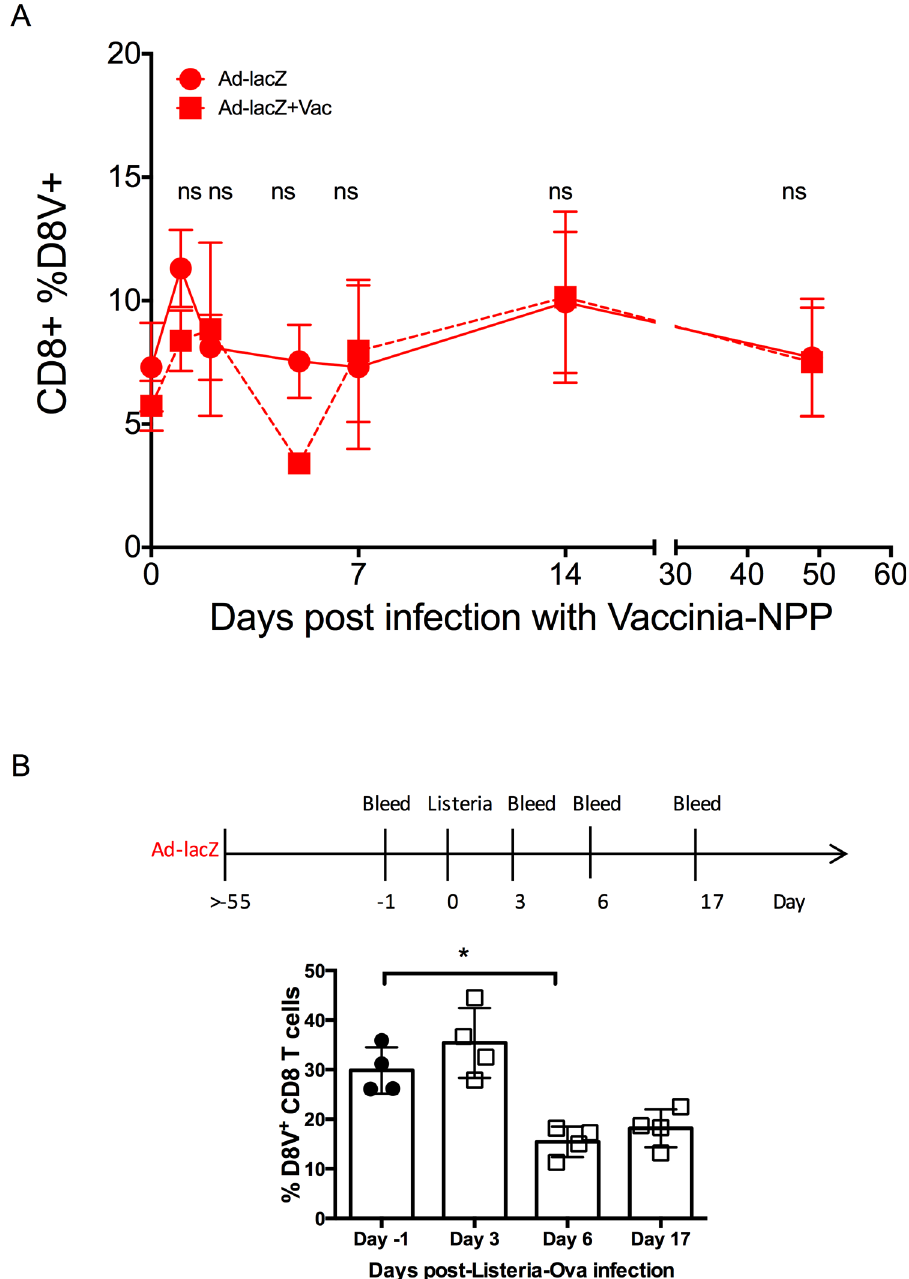
Fig 7. Effect of other infections on pre-existing Ad-lacZ memory responses. (A) C57BL/6 mice were first immunized with Ad-lacZ and then 50 days later were infected with vaccinia i.p. The levels of pre-existing CD8 + D8V + in the blood after vaccinia infection was measured by ex vivo tetramer staining (N = 3 from one of two independent experiments). (B) Mice were immunized with Ad-lacZ, then > 55 days later were infected with i.v. with 1x10 3 cfu/200μl Listeria-OVA. Blood was collected at the indicated timepoints, and the levels of CD8 + D8V + cells measured by surface staining. p values were obtained using T-tests (cid:3) p < 0.05. tetramer + population 6 days after primary Ad-lacZ immunization (Fig 8C), where CD44 + CD62L - phenotype comprised the minority population (16.8%). This would again imply that